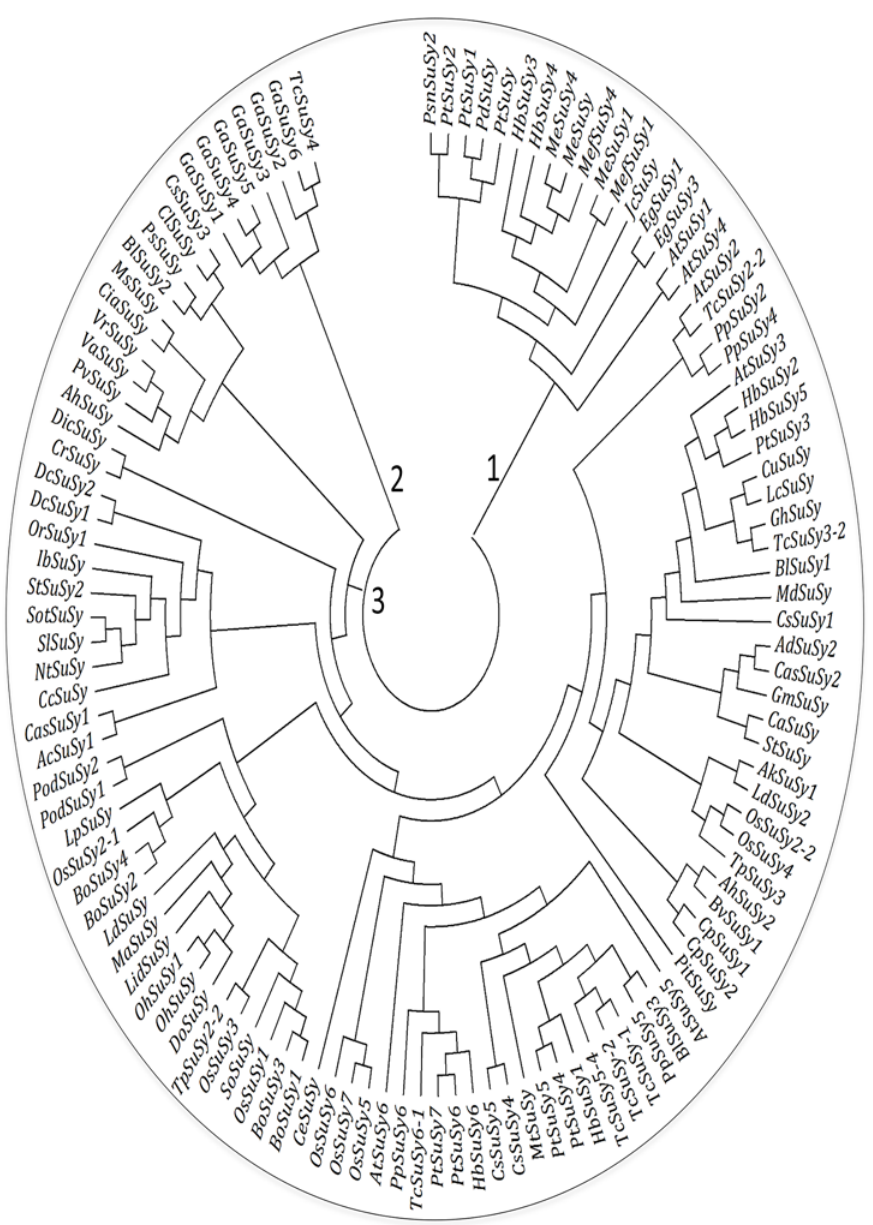
Fig 1. Phylogenetic tree of selected full SuSy coding sequences derived using the neighbor-joining method. The sequences were obtained by translating the following 116 full-length cDNA sequences of SuSy isozymes downloaded from Genbank (http://www.ncbi.nlm.nih.gov/genbank): Arabidopsis thaliana (AtSuSy1 – 6) isozyme1 – 6 (At5g20830, At5g 49190, At4g02280, At3g43190, At5g37180,